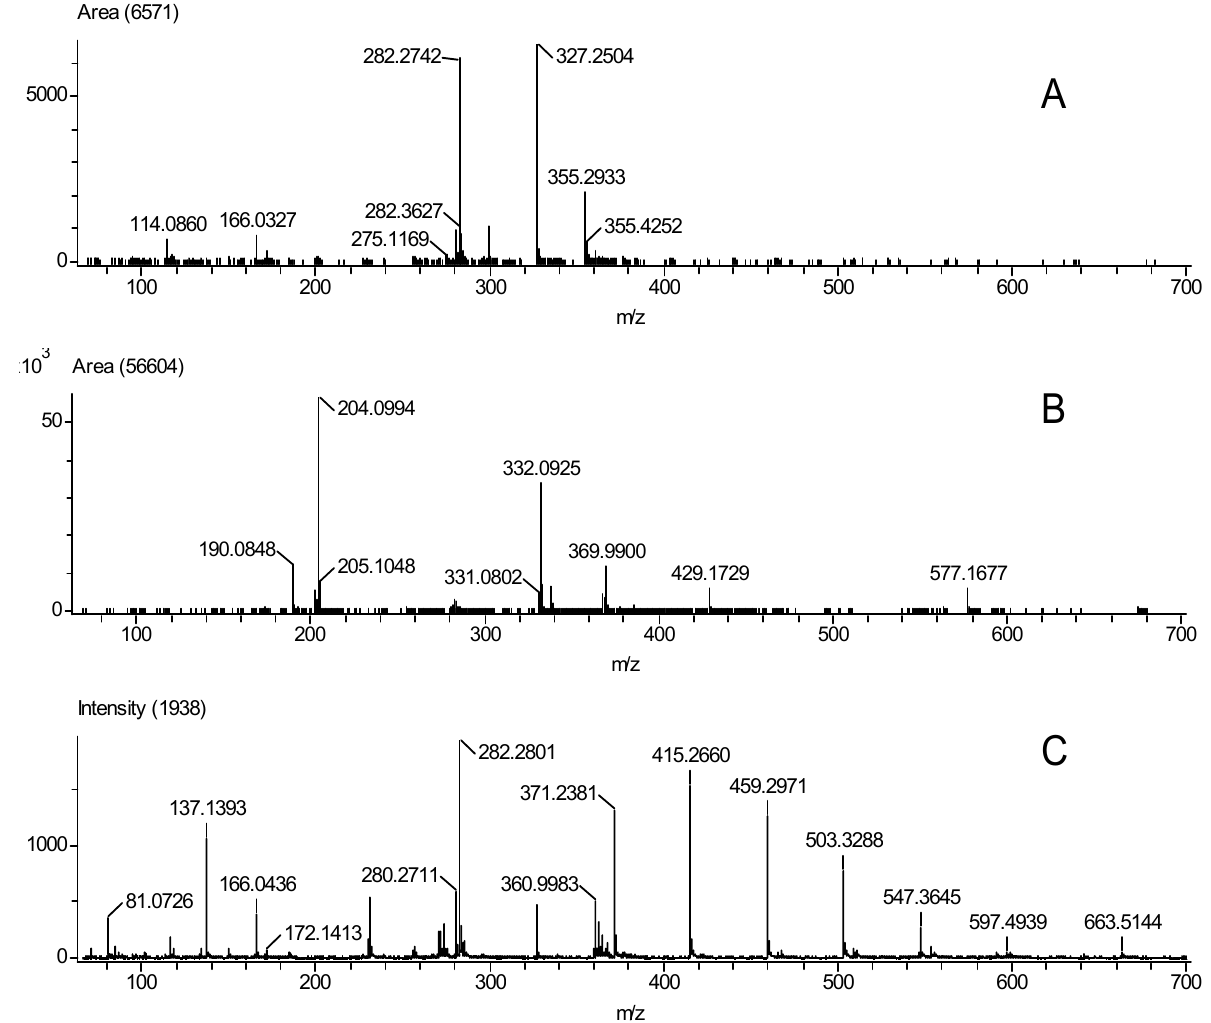
Figure 9. Mass spectra for carpet samples ( A ) 19 (nylon), ( B ) 20 (polyester) and ( C ) 21 (olefin) at 30 V.